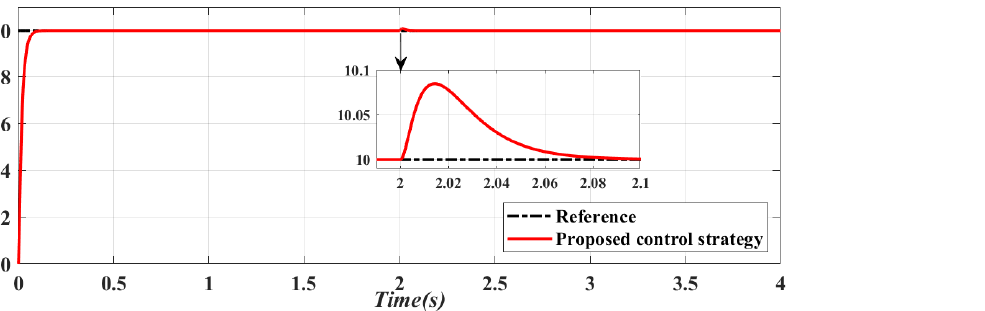
Figure 6. Tracking curve for reference